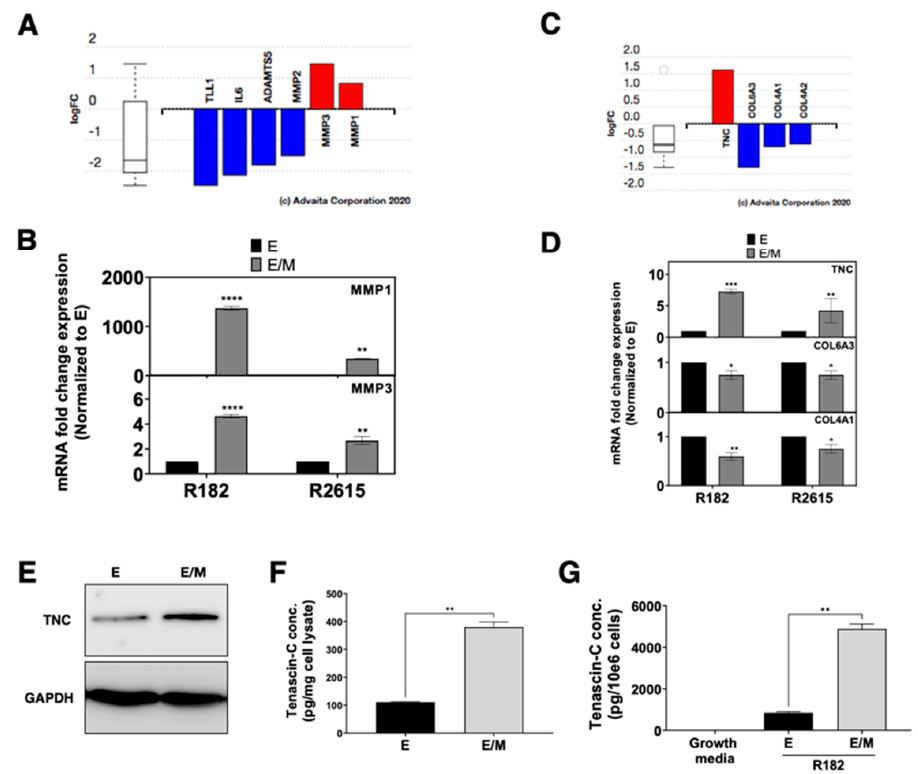
Figure 5. Differentially expressed genes (DEGs) related to ECM disassembly and organization in the E/M hybrid compared to the E cells. (A) Bar plot of log2 fold change (logFC) of DEGs related to ECM disassembly. (B) Validation of MMP1 and MMP3 mRNA expression quantified by q-PCR in the E/M and M state from the R182 and R2615 cells. Bars represent the means ± SEM; p-value ** < 0.01 and **** < 0.0001, n.s. = non-significant. One-way ANOVA was used to define the p-value. (C) Bar plot of the log FC of DEGs related to ECM organization. (D) Validation of Tenascin-C (TNC), Collagen6A3 (COL6A3), and Collagen4A1 (COL4A1) mRNA expression quantified by q-PCR in the E/M and M state from the R182 and R2615 cells. Bars represent the means ± SEM; p-value * < 0.05, ** < 0.01 and *** < 0.001, n.s. = non-significant. One-way ANOVA was used to define the p-value. (E) Cellular TNC protein expression in E and E/M state of R182. Quantification of TNC using ELISA for (F) intracellular and (G) extracellular (secreted) expression. Bars represent means ± SEM; p-value ** < 0.01. Student t-test was used to define the p-value.